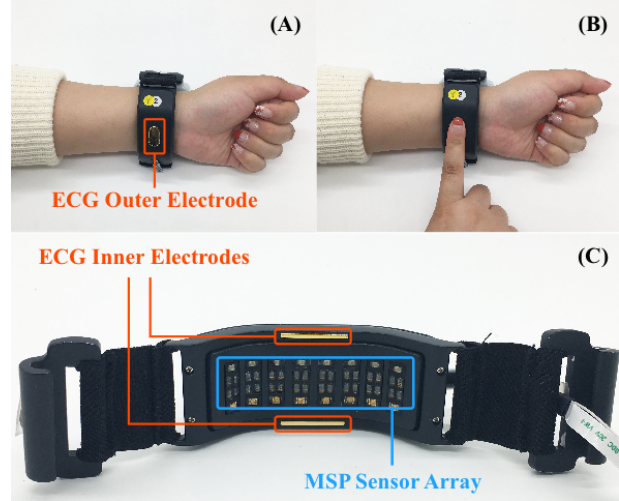
Figure 11. Snapshots of our in-house data acquisitions for ECG ( A , B ) and MSP ( C ). One wearable ECG sensor contacts the wrist of the left arm ( A ) and a subject must touch ECG sensors with their index finger of the right hand to acquire ECG data to measure the potential difference between left wrist and right finger ( B ). MSP sensor array is placed on the right wrist to measure the data ( C